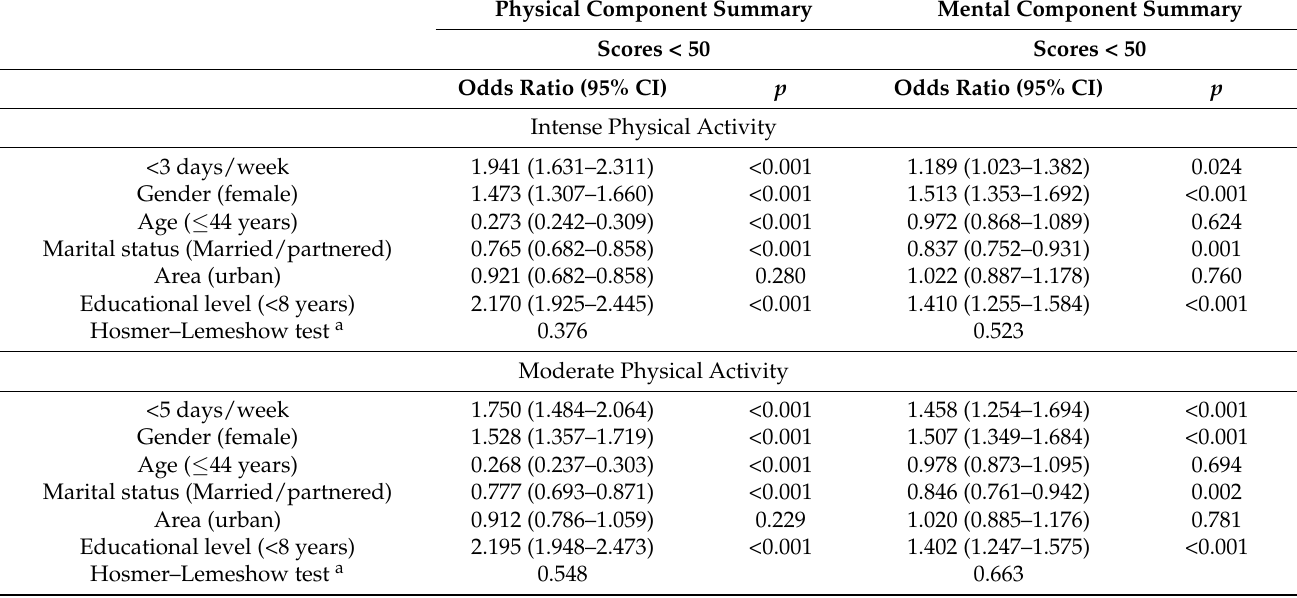
Table 6. Logistic regressions for the association between the physical and mental health components according to physical inactivity and sedentary behavior, adjusted for sociodemographic